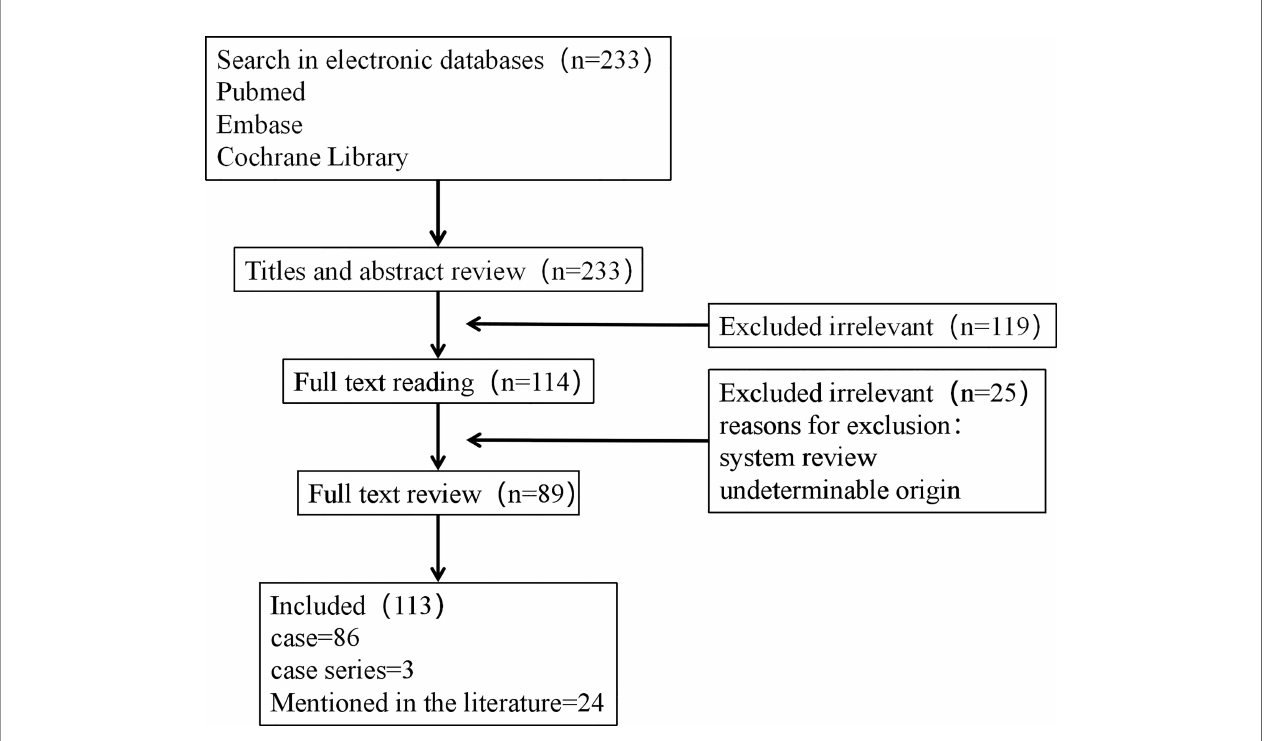
FIGURE 1 | Flowchart of the